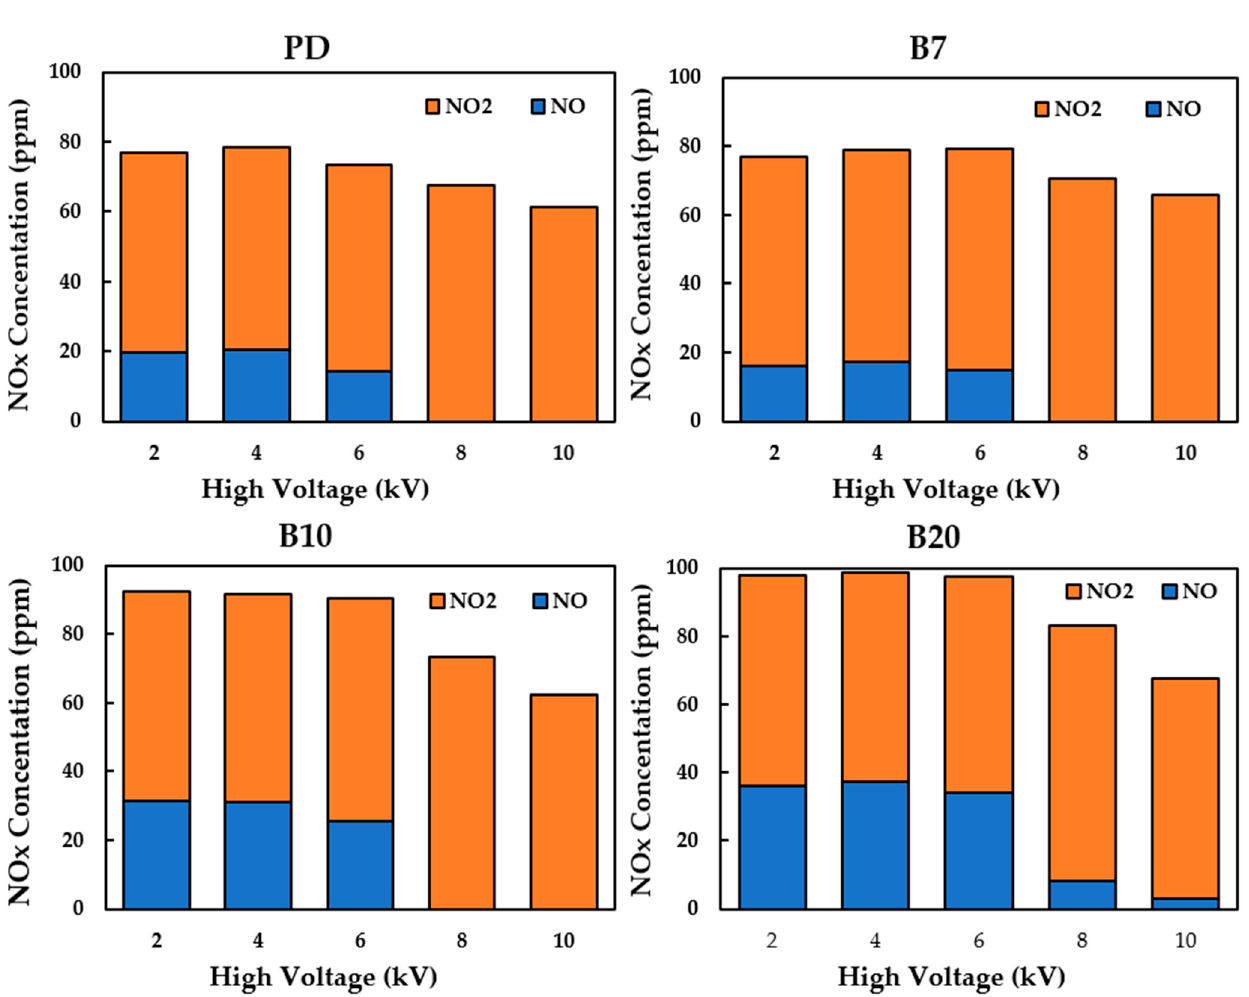
Figure 5. Effect of NTP on NO and NO 2 conversion at an engine speed of 2000 rpm and IMEP 6